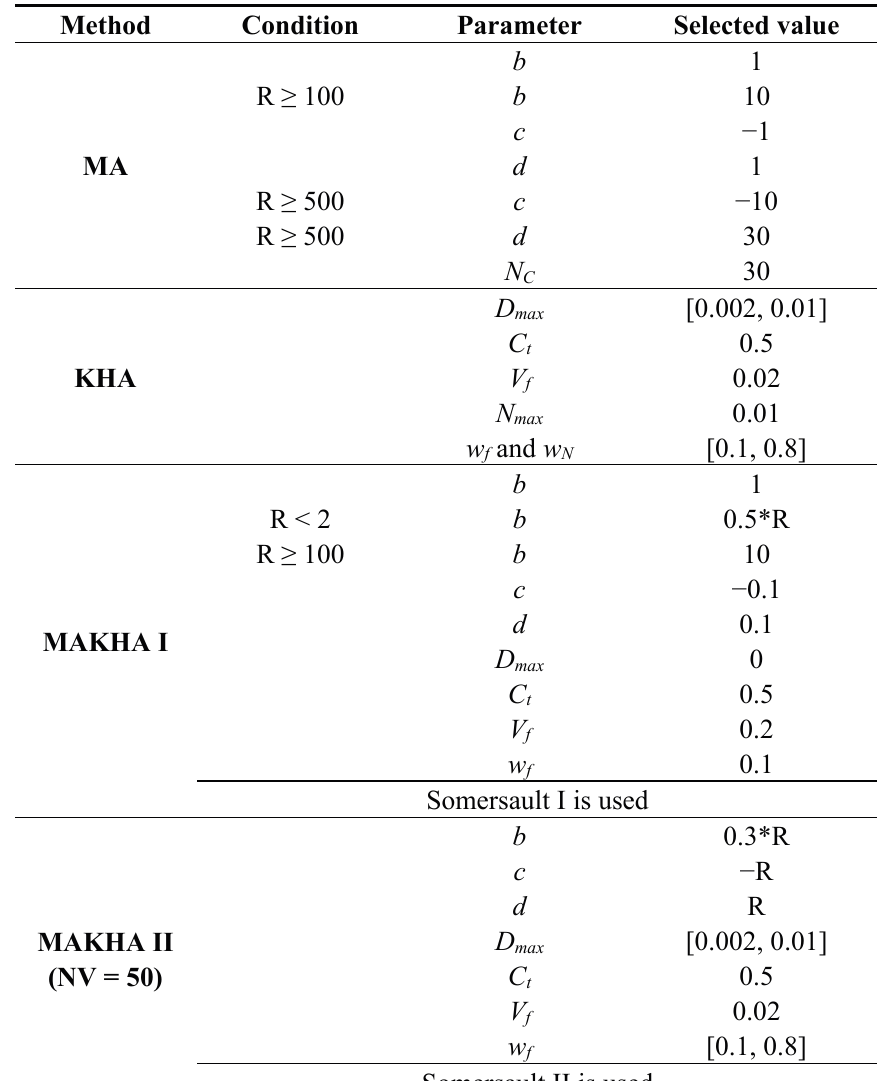
Table 3. Selected values of the parameters used in the implementation of MA, KHA and